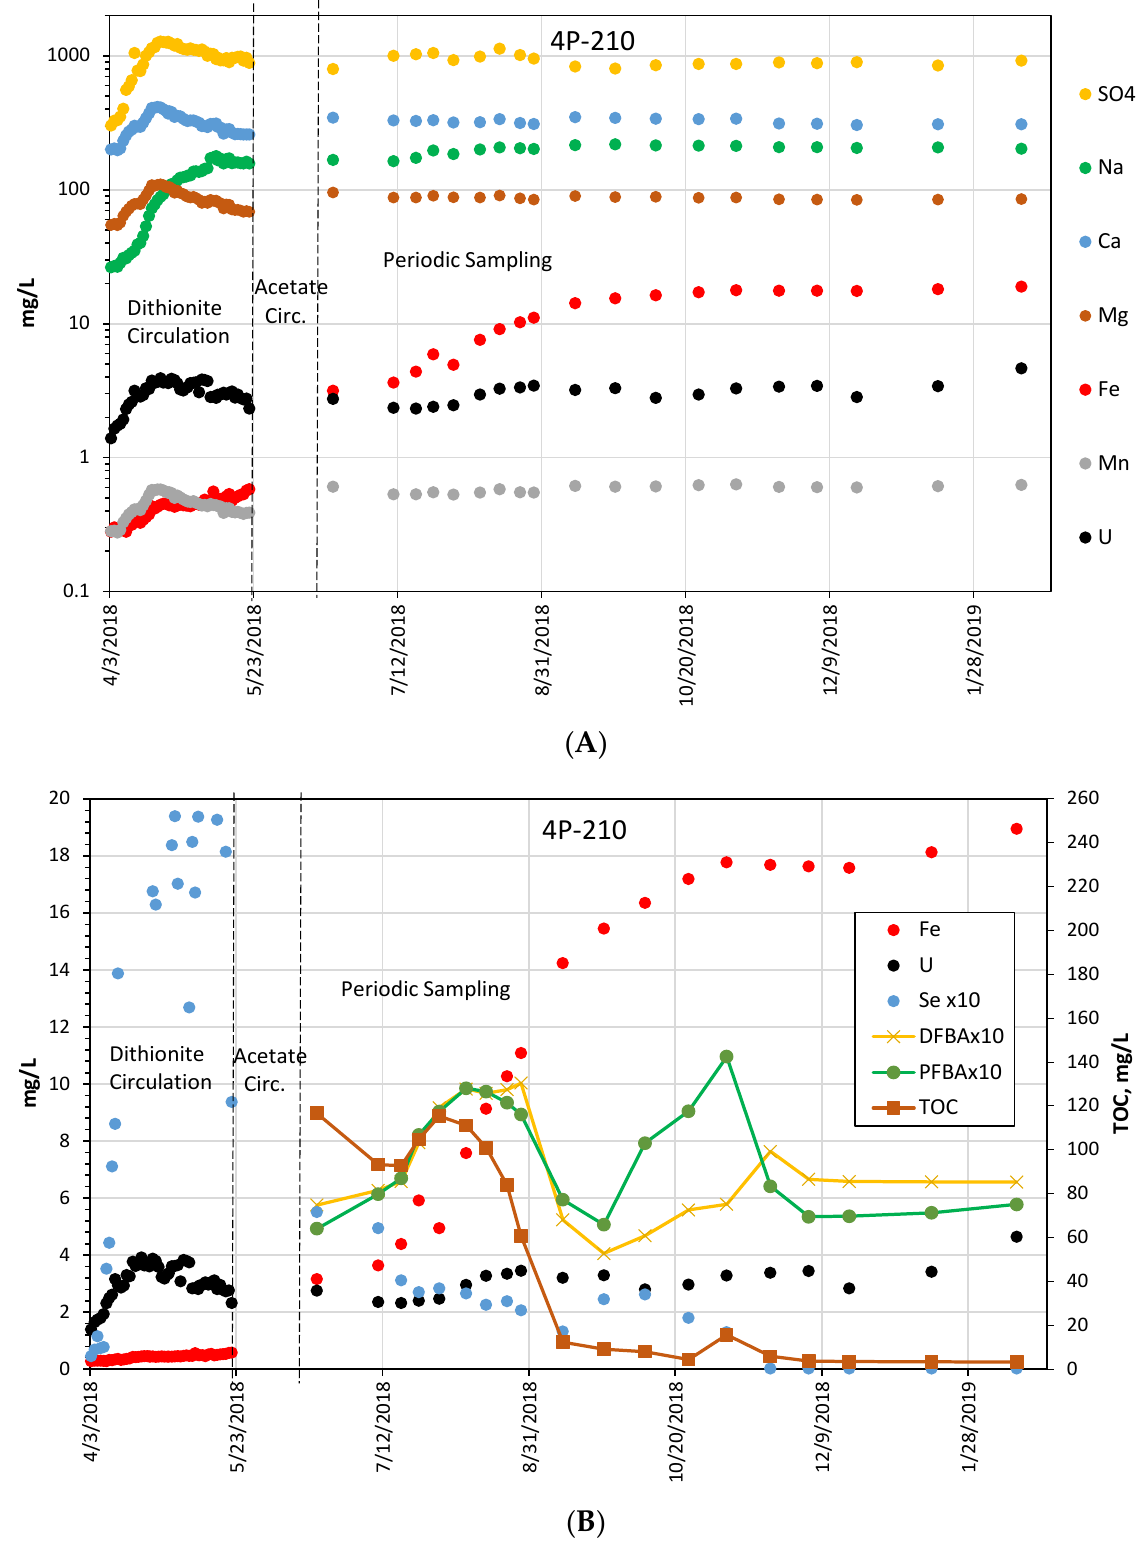
Figure 4. ( A ) Concentration histories of several key constituents in production well 4P-210 during the amendment test. ( B ) Concentration histories of redox-sensitive constituents (Fe(II), U, Se), TOC (as acetate surrogate), and tracers. Note that Se, difluorobenzoate (DFBA), and pentafluorobenzoate (PFBA) concentrations are ×10.